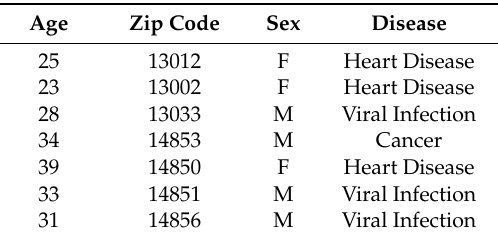
Table 4. Attribute and tuple partition.